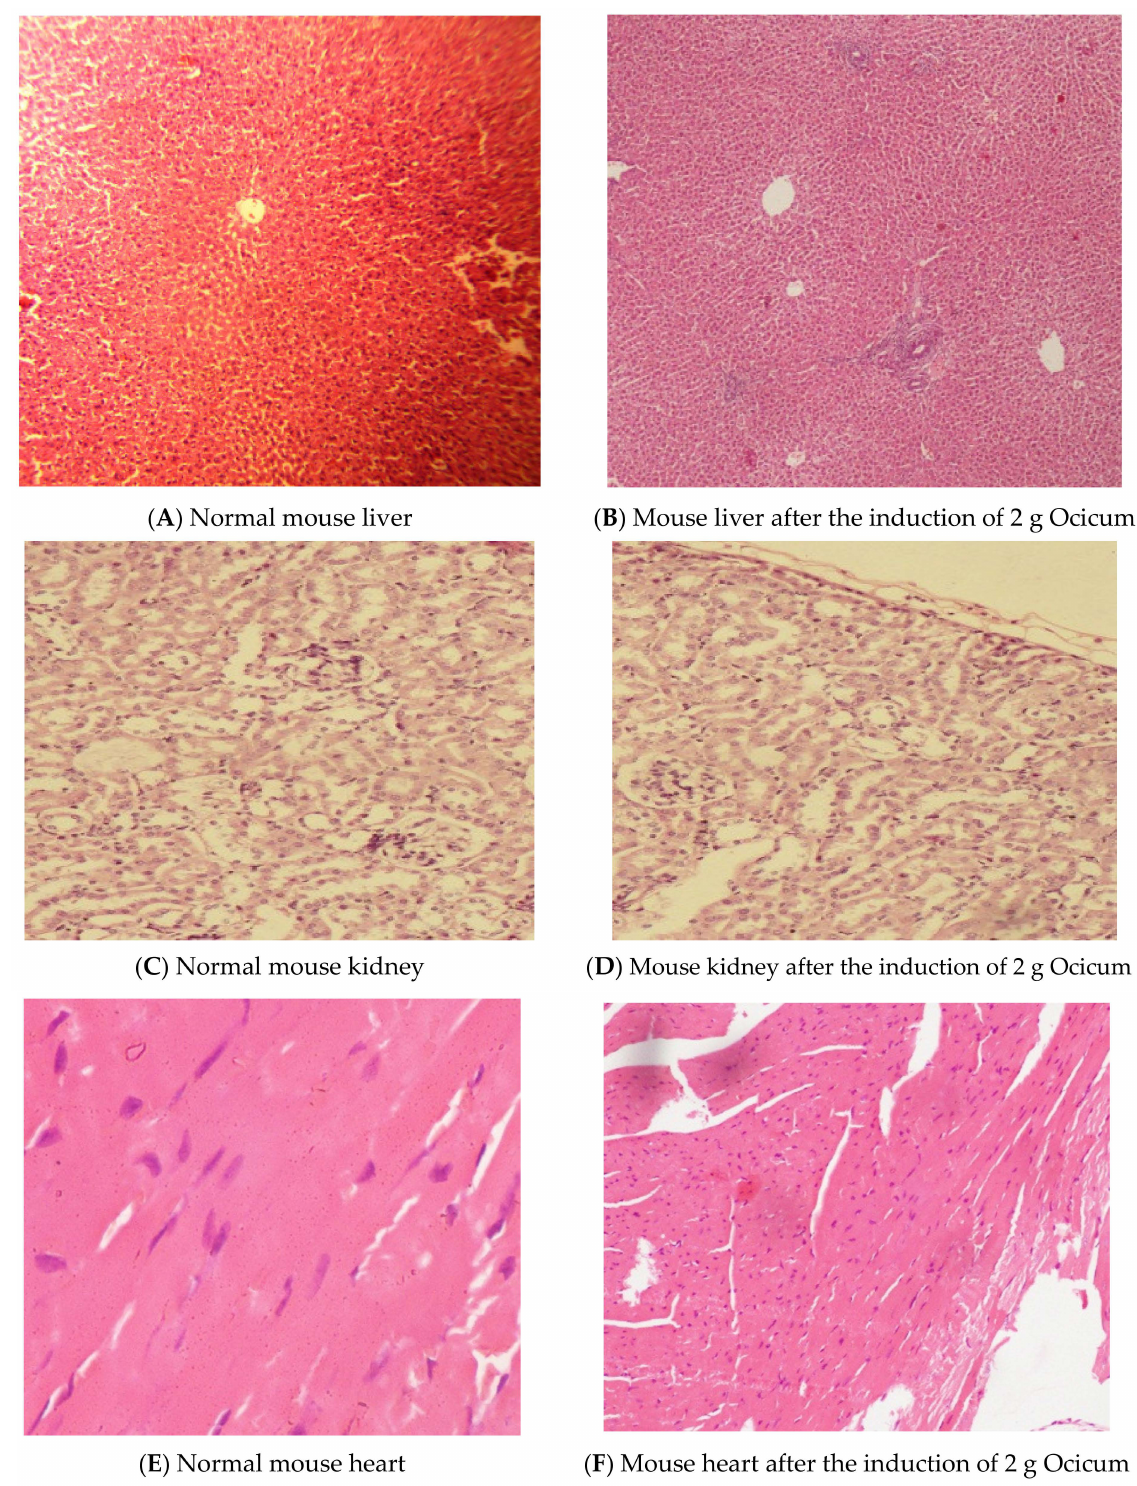
Figure 2. Histology of mouse liver, kidney and heart before and after the induction of 2 g Ocicum. Poloxamer-fabricated solid dispersions of ACF prepared by the solvent-evaporation method as shown in Figure 3B displayed an N-H stretch at 3320 cm − 1 and exhibited C=O stretches at 1717, 1712, 1717 cm − 1 for SE-ACF-1, SE-ACF-2 and SE-ACF-3, respectively. Moreover C-O-C peaks for all three formulations occurred at 1243 cm − 1 and C-Cl peaks were illustrated at 745 cm − 1 for SE-ACF-1, SE-ACF-2 and